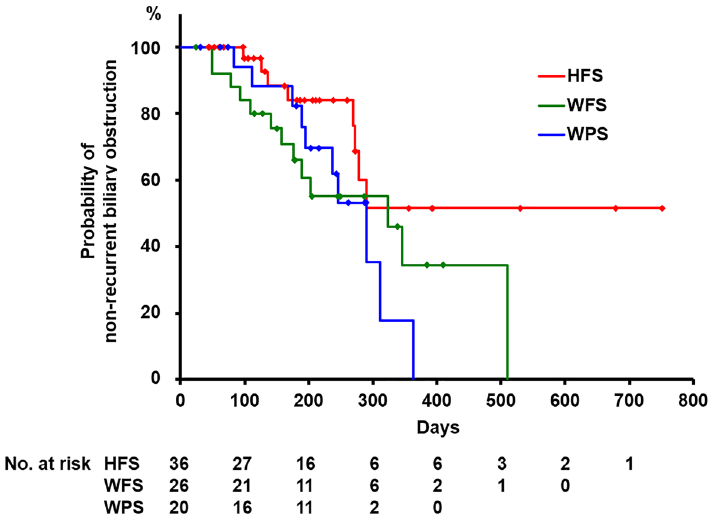
Figure 3. Kaplan–Meier plots for the estimation of the TRBO. Median TRBO was not reached in the HFS group, while 290 and 323 days in the WPS and WFS group, respectively ( p = 0.108). TRBO of the HFS group was significantly longer than that of the WFS group ( p = 0.049), and tended to be longer than that of the WPS group ( p = 0.074). TRBO Time to recurrent biliary obstruction, HFS HILZO fully covered stent, WPS WALLFLEX biliary RX partially covered stent, WFS WALLFLEX biliary RX fully covered